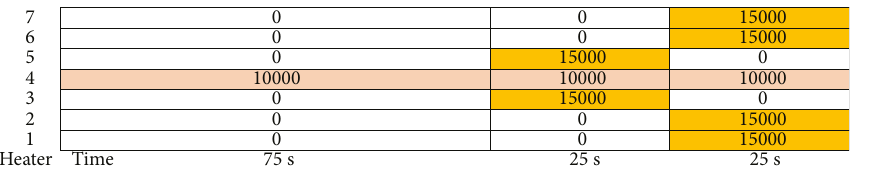
Figure 10: Initial heating sequence of in- fl ight case (power in W/m2).